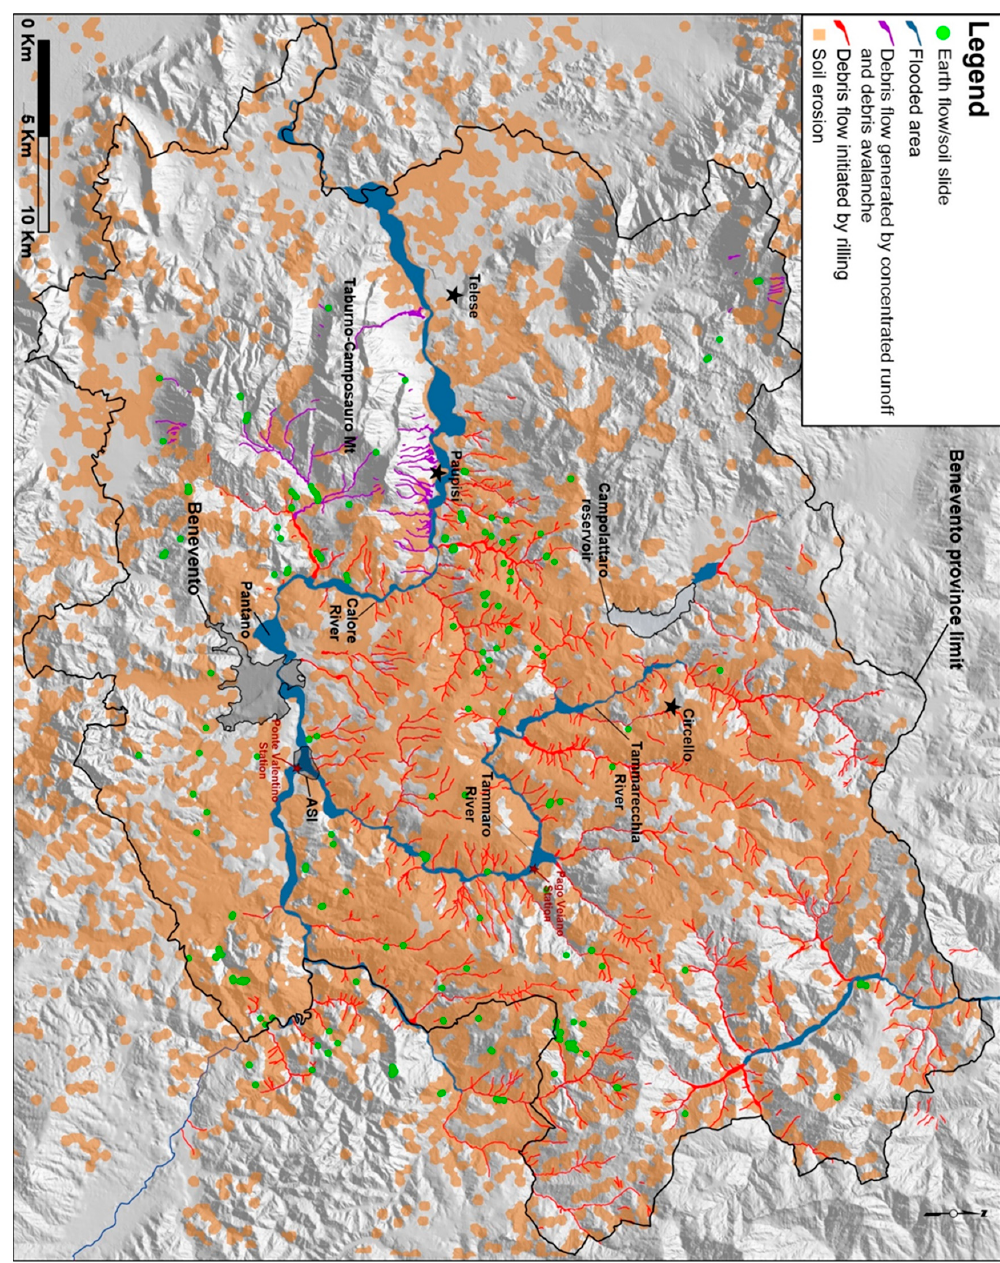
12 of 23 Table 2. Main morphometric features of the flooding and hillslope processes. F, Floods; SE, Soil Erosion; EF, Earth Flow; D, Frun; Debris Flows generated by concentrated runoff; D, Fril; Debris Flows initiated by rilling. Storm